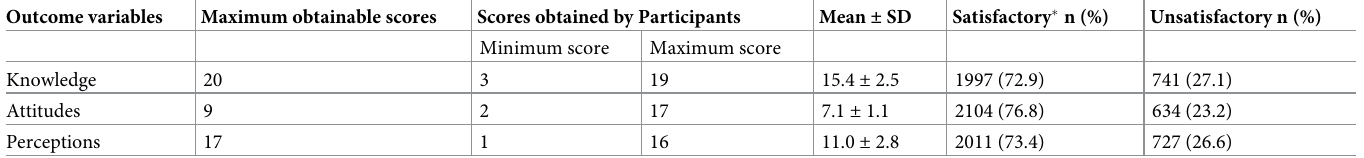
Table 2. Description of obtainable scores (outcomes) by participants (n = 2738). Outcome